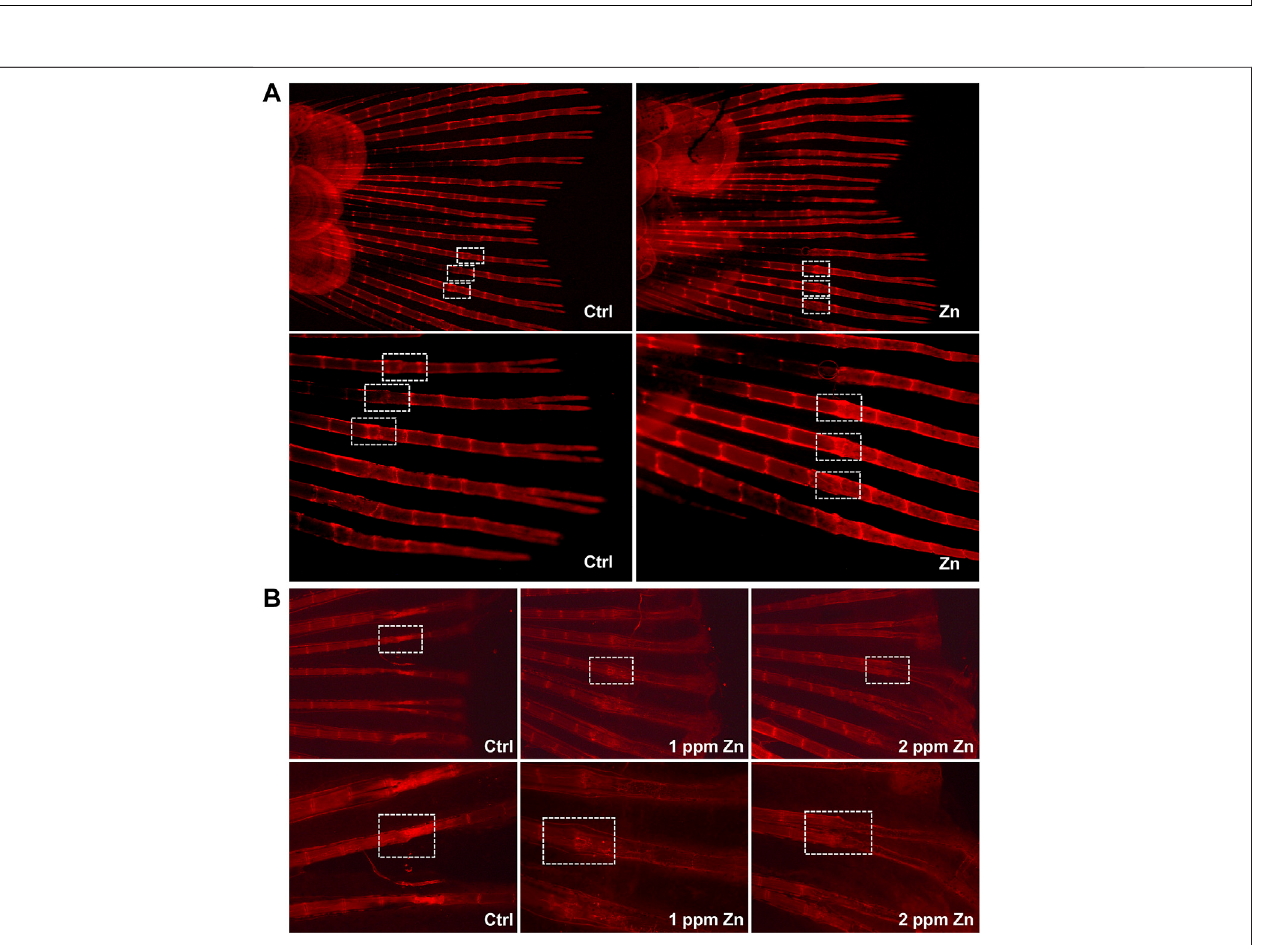
FIGURE 3 | Zebra fi sh fi n amputation and regeneration test. (A) Effect of the control group and Ti-NW-Zn surface on osteogenesis; (B) effect of different concentrations of zinc ions on osteogenesis: 0, 1, and 2 ppm.